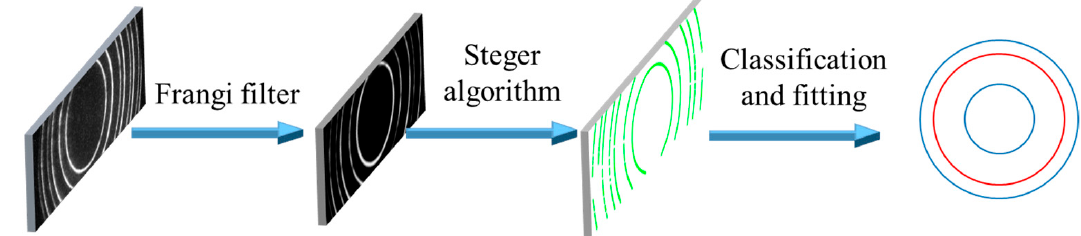
Figure 4. Schematic diagram of the spectral processing process.